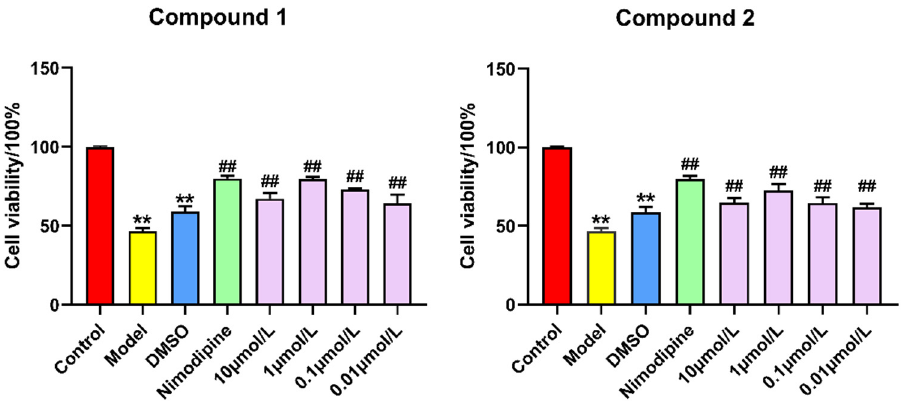
Figure 6. Effects of compounds 1 and 2 on cell viability in OGD-induced PC12 cells. The values represent mean ± SD ( n = 6). ** p < 0.01 vs. the control group; ## p < 0.01 vs. the model group.